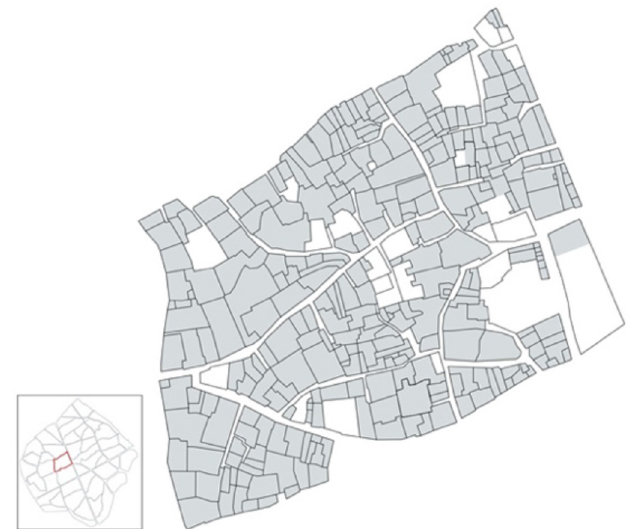
Fig. 6. A close up to one of the blocks of the Old